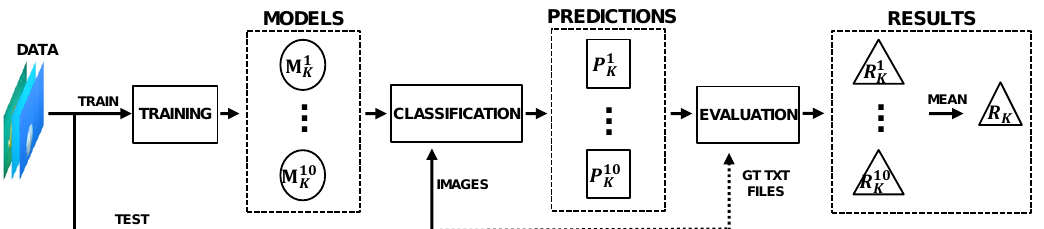
Figure 5. Experiment K validation process. For each one of the twelve hyperparameter combinations, the network was trained ten times using the k-fold cross-validation method, outputting ten models. These models were run and evaluated over the test data. Finally, the results of the models were obtained and its mean performance